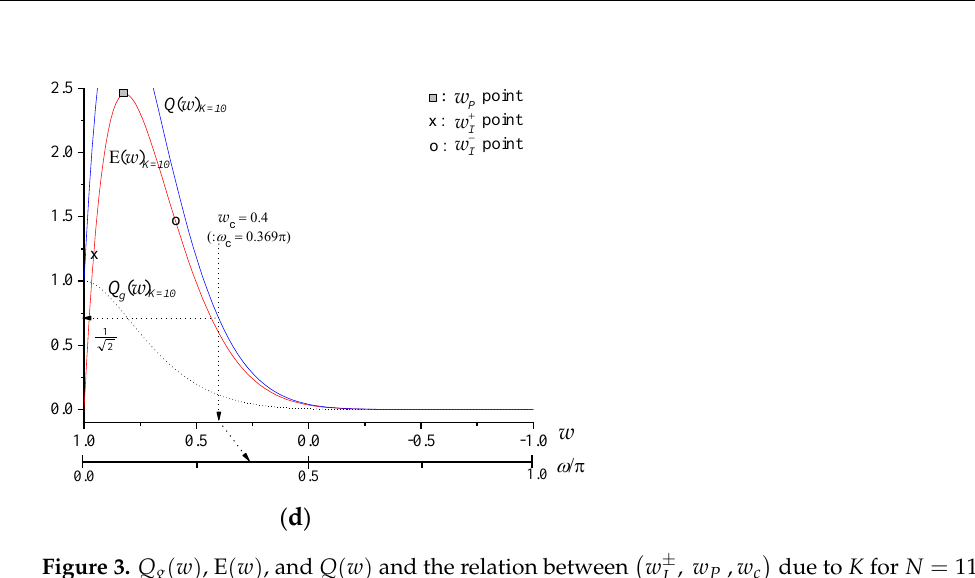
Figure 3. 𝑄 𝑔 (𝑤) , Ε(𝑤) , and 𝑄(𝑤) and the relation between ( 𝑤 𝐼± ,𝑤 0.369𝜋 ): ( a ) 𝑤 𝐼+ < 𝑤 𝑐 as 𝐾 = 5 , ( b ) 𝑤 𝑃 < 𝑤 𝑐 < 𝑤 𝐼+ as 𝐾 = 7 , ( c ) 𝑤 𝐼− < 𝑤 𝑐 < 𝑤 𝑃 as 𝐾 = 9, and ( d ) 𝑤 c < 𝑤 𝐼− as 𝐾 = 10 .